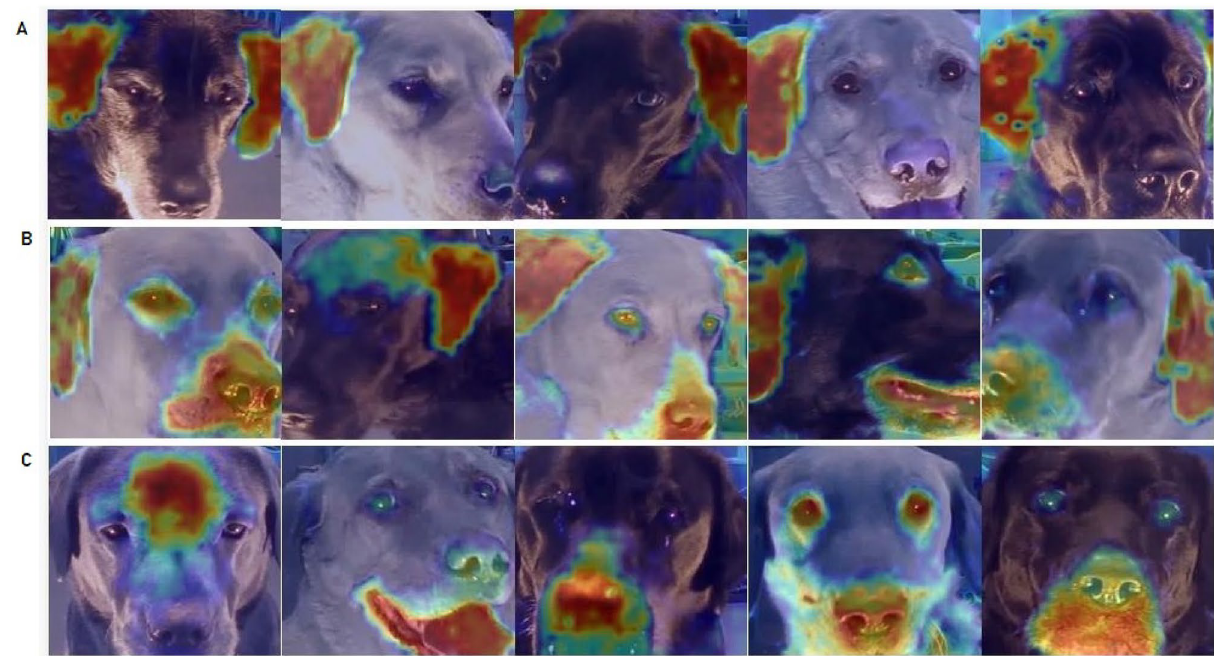
Figure 7. Exploring frames with ‘Ears Flattener’ correctly classified as negative condition. Category ( A ) focus only on ears; Category ( B ) focus on ears and other facial parts; Category ( C ) focus on other facial parts.